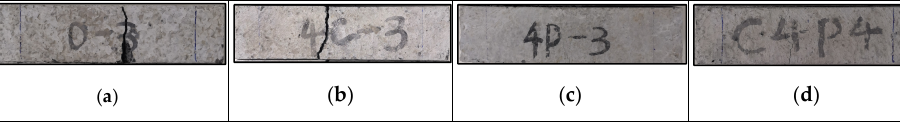
Figure 11. Flexural failure mechanism for LWAC specimens reinforced with: ( a ) no fiber, ( b ) single carbon fiber, ( c ) single polypropylene fiber, ( d ) hybrid fibers.